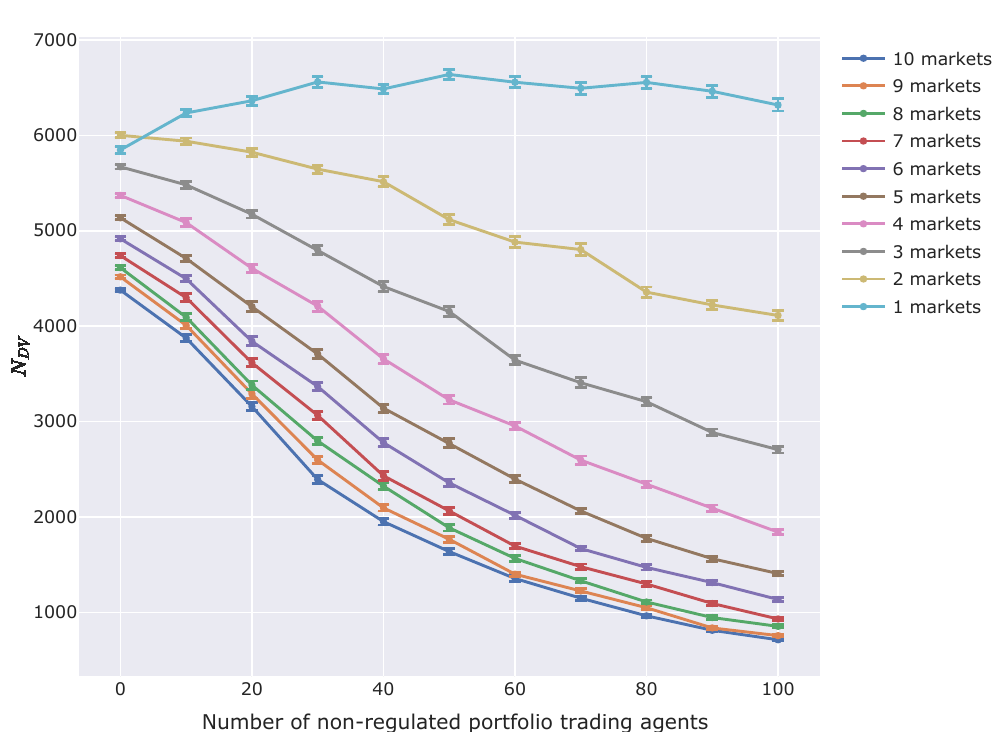
Figure 6. N DV of experiments assessing the effect of portfolio trading agents. The horizontal axis is the number of non-regulated portfolio trading agents, and the vertical axis in the number of steps in which the market price is below exp ( − 0.1 ) times the fundamental price. (Details are explained with Equation (14)). Each series of plots shows results for the corresponding number of markets in the simulation. Error bars show standard